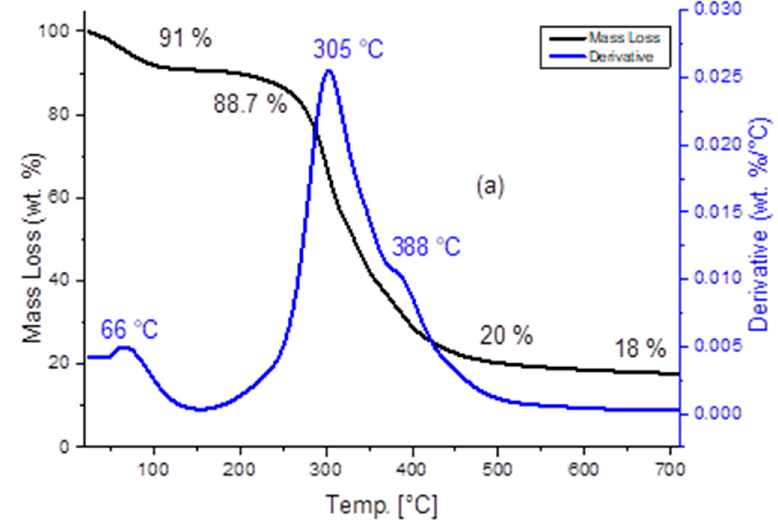
Figure 5. TGA of WBCP under argon.